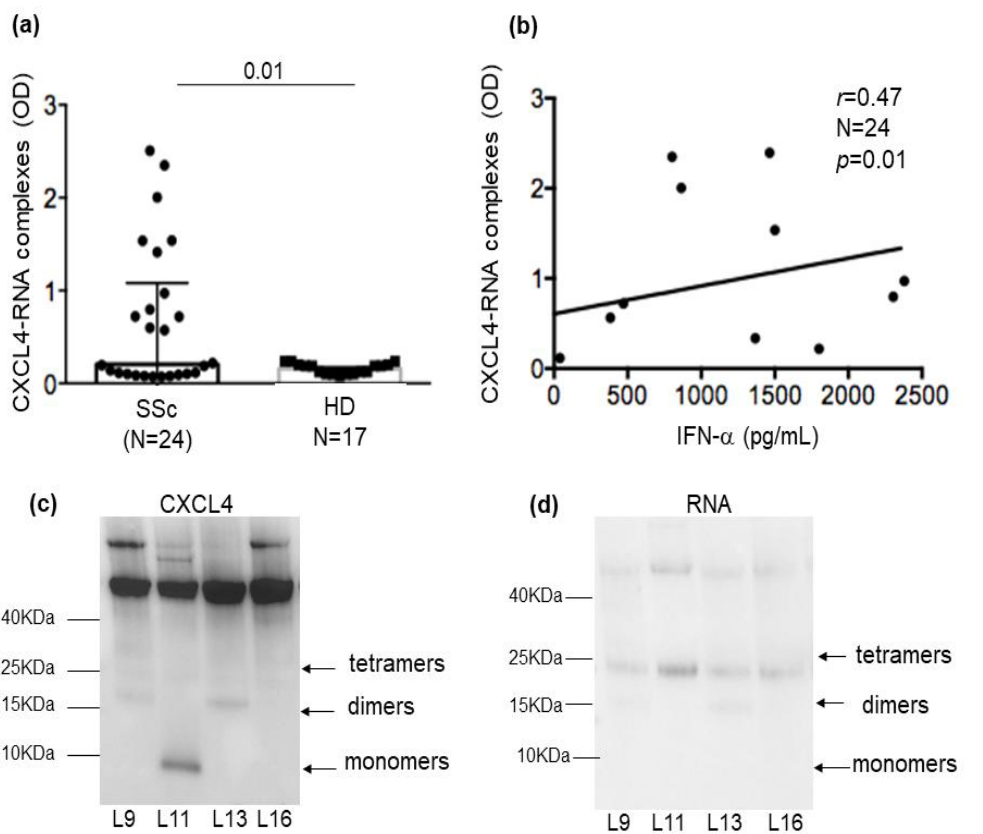
Figure 2. ( a ) CXCL4-RNA complexes are present in SSc plasma. Immune complexes of RNA with CXCL4 were determined with an in-house ELISA (see Methods) and results are expressed as optical density (OD) in SSc patients and HDs. Horizontal bars are the means; vertical bars are standard errors of the mean (SEM); p -values are from the Mann–Whitney test. ( b ) OD values were plotted against IFN- α concentrations measured in the SSc plasma. Correlation was calculated by Spearman’s correlation test. Coefficient of correlation r, significance p, and sample size N are indicated in the figure. ( c ) CXCL4 was immune-precipitated using an anti-CXCL4 antibody from the plasma of SSc patients, and the immune-precipitated material was separated by SDS-PAGE (10–20% Tricine gel) and transferred to nitrocellulose. The blot was probed with a monoclonal anti-CXCL4 antibody ( c ) and a polyclonal anti-RNA antibody ( d ) and revealed by ECL. The arrowheads on the right indicate bands corresponding to major CXCL4 forms. Molecular mass markers are indicated on the